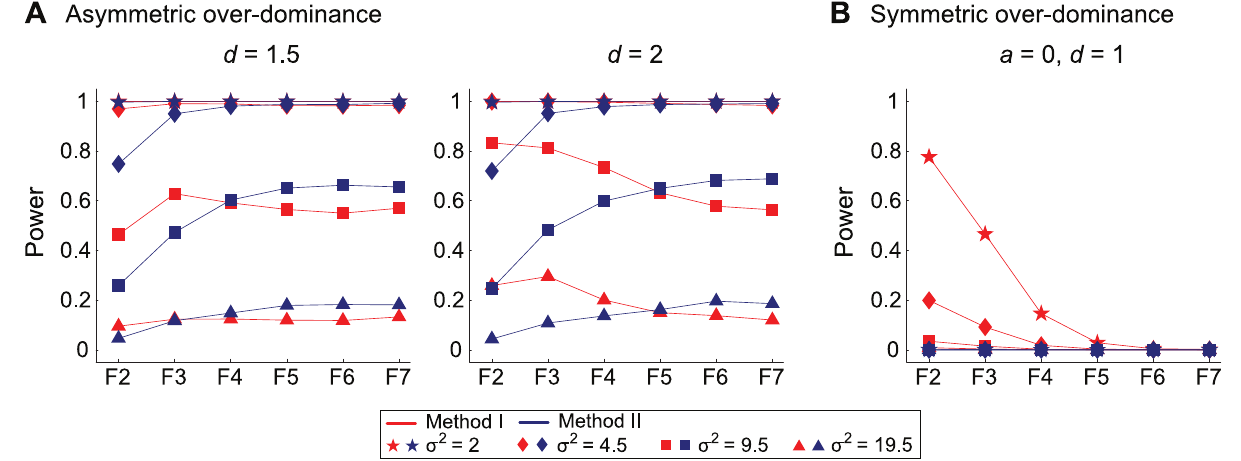
Figure 4. The power of QTL mapping with over-dominance. ( a ) Asymmetric over-dominance. ( b ) Symmetric over-dominance. See text for